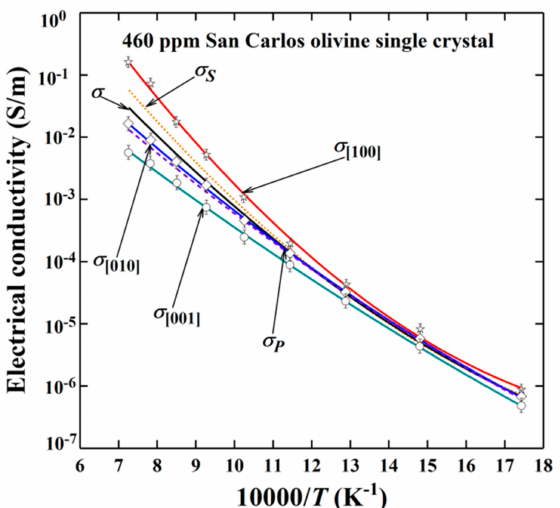
Figure 7. The anisotropic EC of San Carlos olivine single crystals measured at 4.0 GPa over a broad temperature range (573–1373 K). Three di ff erent average schemes of series ( σ s ), parallel ( σ p ) and e ff ective medium models ( (cid:104) σ (cid:105) ) were applied. See text for details. (Reproduced with permission